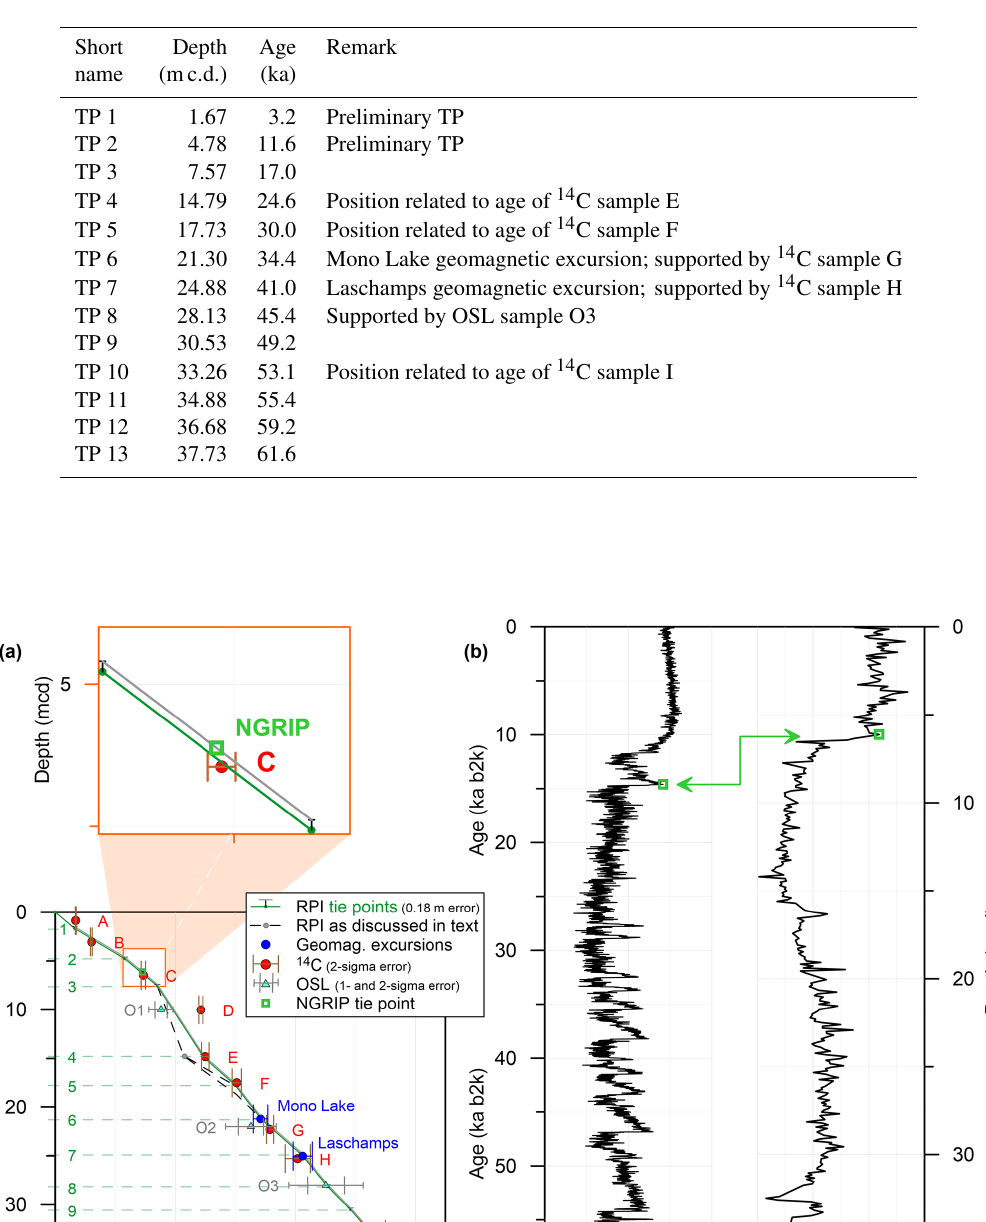
Table 3. Tie points (TP) resulting from correlation of RPI(IRM) of core Co1401 with GLOPIS-75-GICC05.